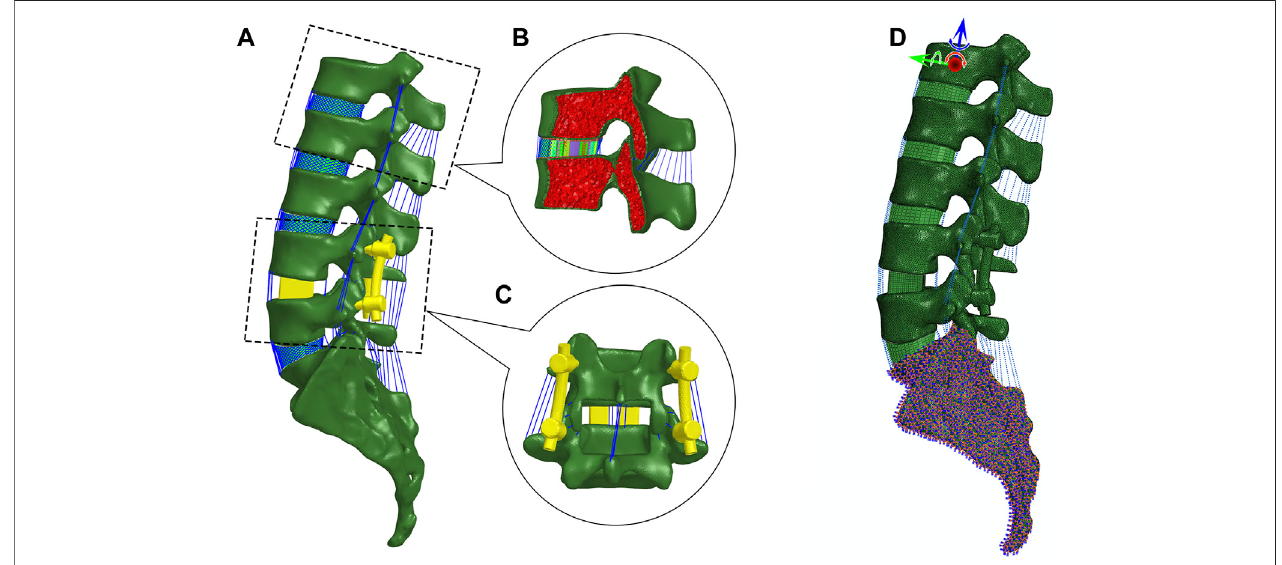
FIGURE 1 | Finite element modeling. (A) Lateral view of the lumbosacral model with posterior lumbar interbody fusion in Hypermesh. (B) Sagittal section of vertebraeandintervertebraldisc.Thevertebraispartitionedintocorticalandcancellousbone.Thedisciscomposedofnucleuspulposusandannulusgroundsubstance embedded with crossing collagen fi bers. (C) Posterior view of PLIF. (D) Boundary and loading